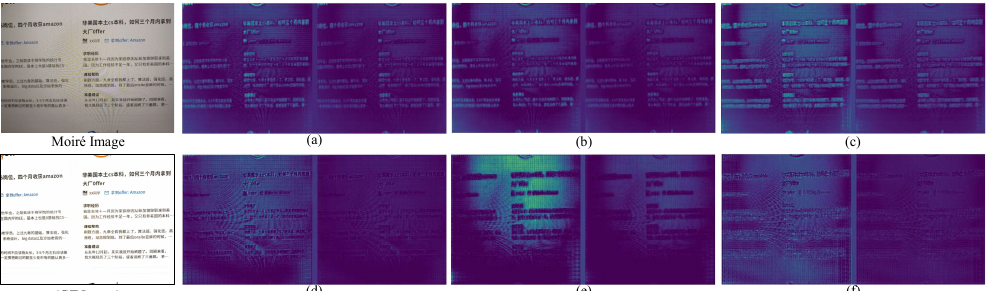
Figure 7. The visualization results of the last frequency domain demoiré block. In ( a – f ), the left side is the original feature maps, and the right side is the weighted feature maps by the last frequency domain demoiré